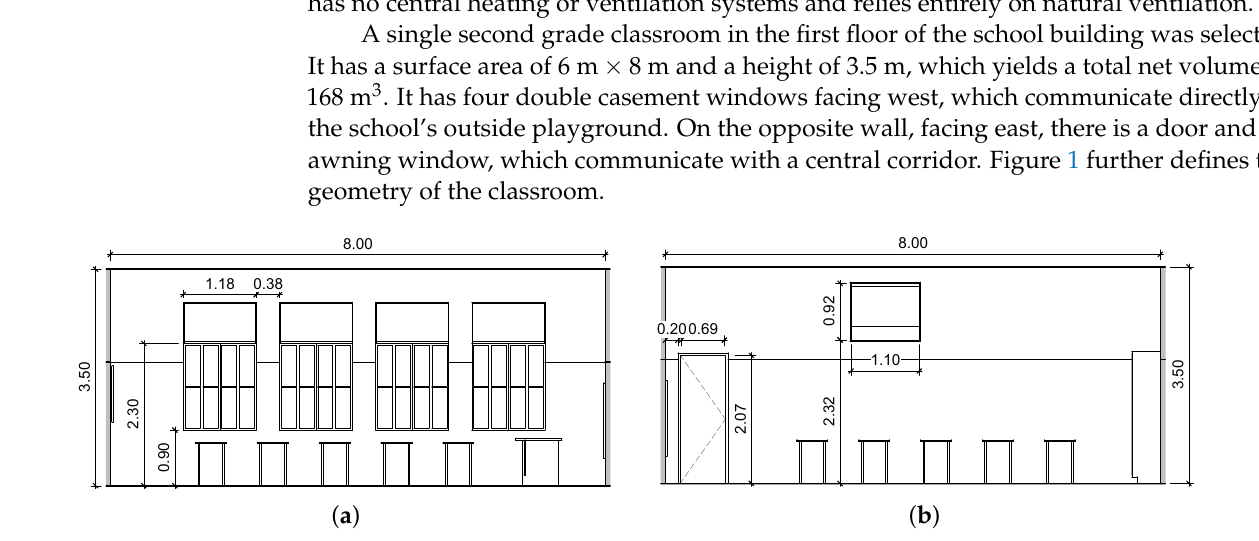
Figure 1. Studied classroom. ( a ) shows the west wall and ( b ) shows the east wall. All dimensions are in